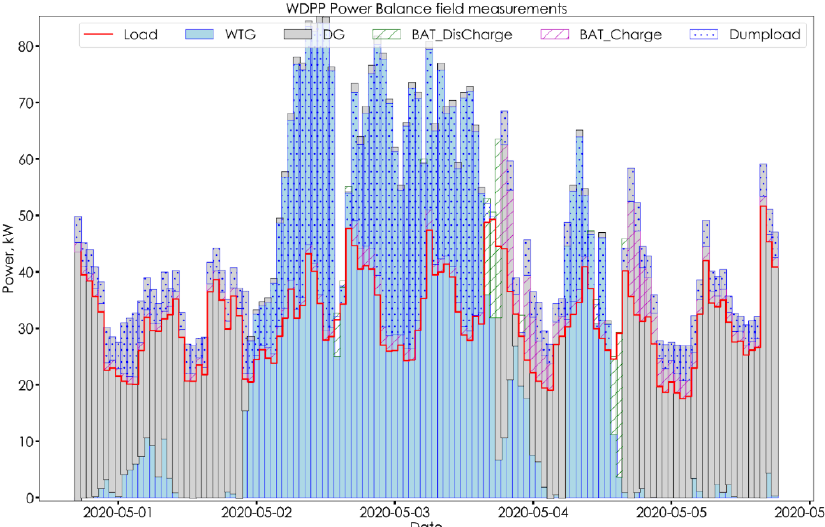
Figure 6. Power balance under the load following mode (SCADA measurements).